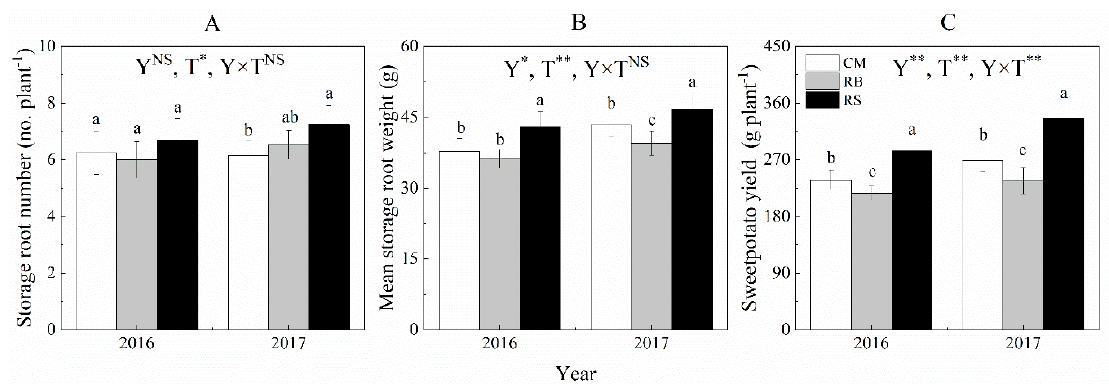
Figure 2. Storage root number ( A ), mean storage root weight ( B ) and sweet potato yield ( C ) under the three N management strategies in 2016 and 2017. Note: CM: conventional N management; RB: 20.0% reduced N was applied as basal; RS: split application of 20.0% reduced N at transplanting and